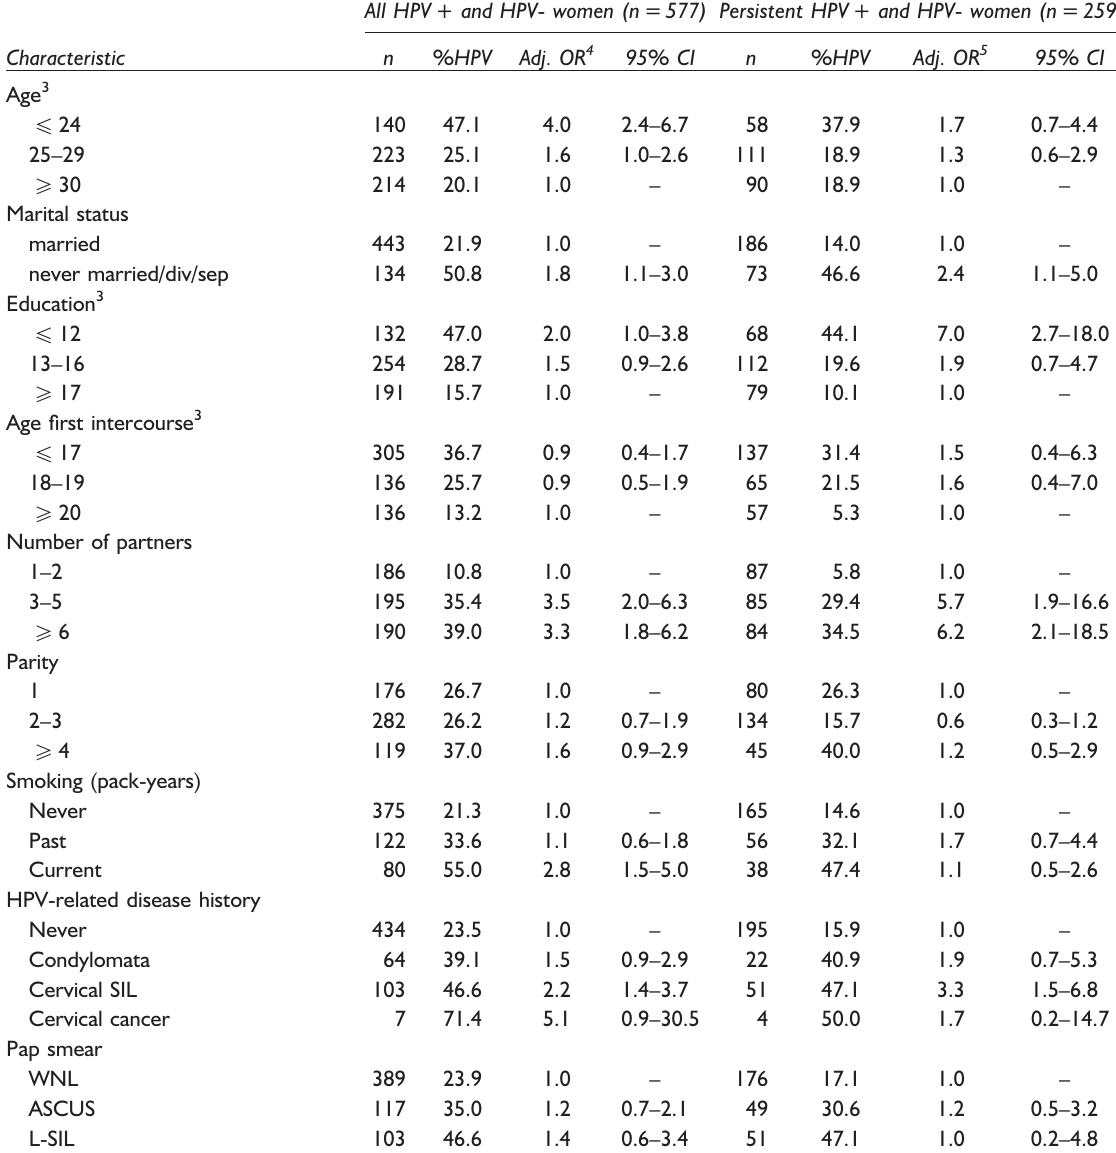
Table 1 Baseline demographic characteristics and risk factors for HPV in the cervix of pregnant women ( n =577) All HPV + and HPV- women (n =577) Persistent HPV + and HPV- women (n =259)